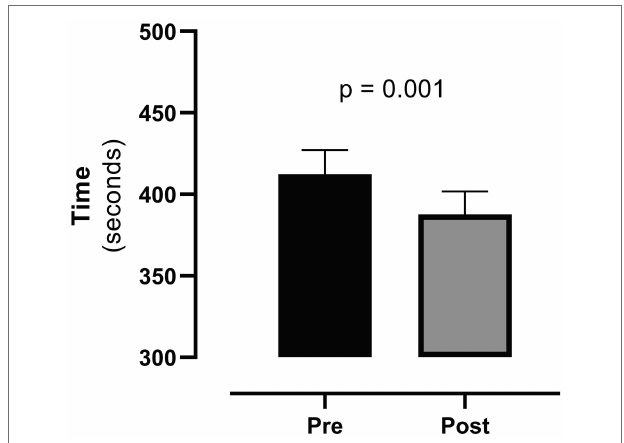
FIGURE 1 | Cumulative time of non-fixed execution and speed ADLs before (pre) and after (post) cardiac rehabilitation. The boxes refer to mean and bars refer to standard error mean (SEM).